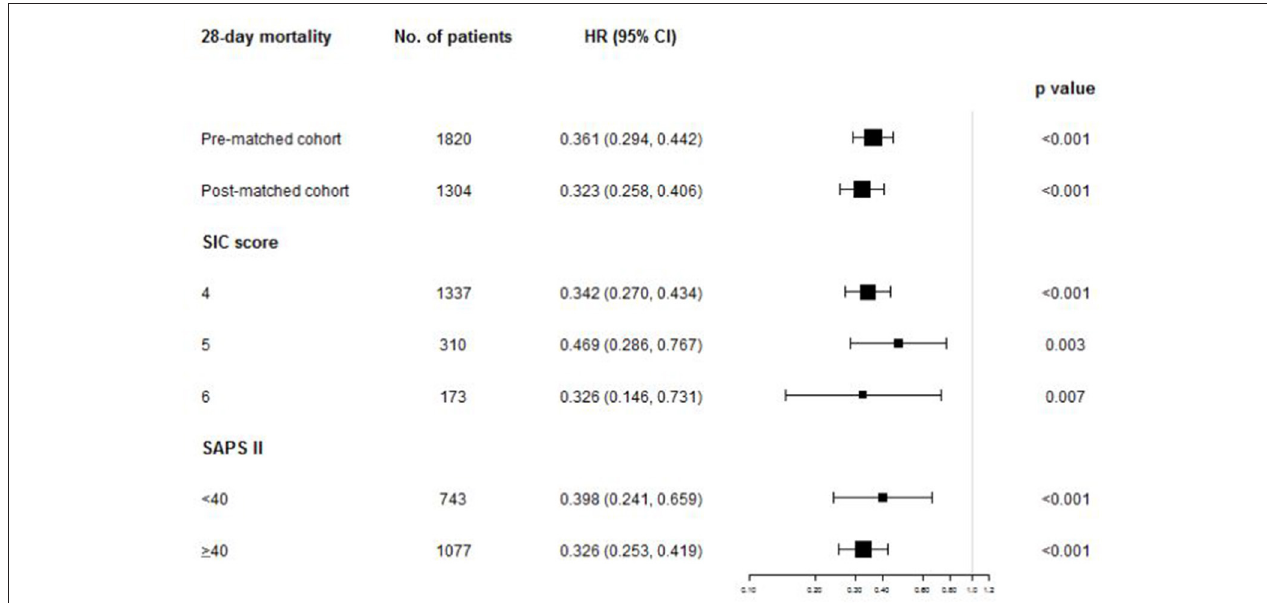
FIGURE 3 | The association between UFH administration and 28-day mortality in overall population and subgroups. HR, hazard ratio; CI, confidence interval; SIC, sepsis-induced coagulopathy; SAPS II, Simplified Acute Physiology Score II